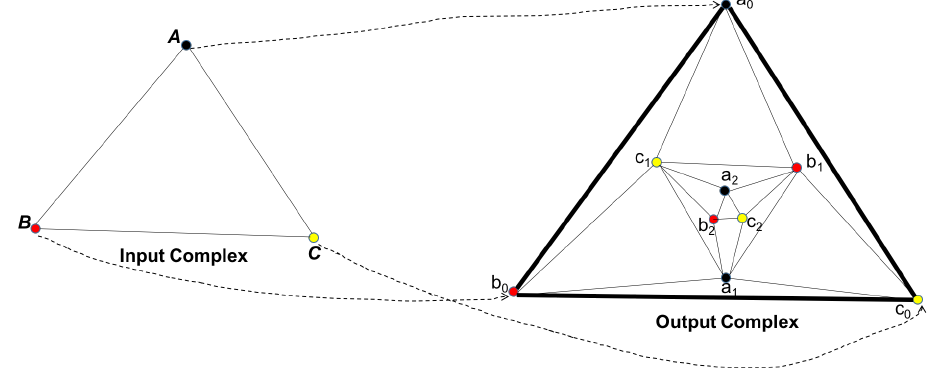
Figure 3. A standard input-less